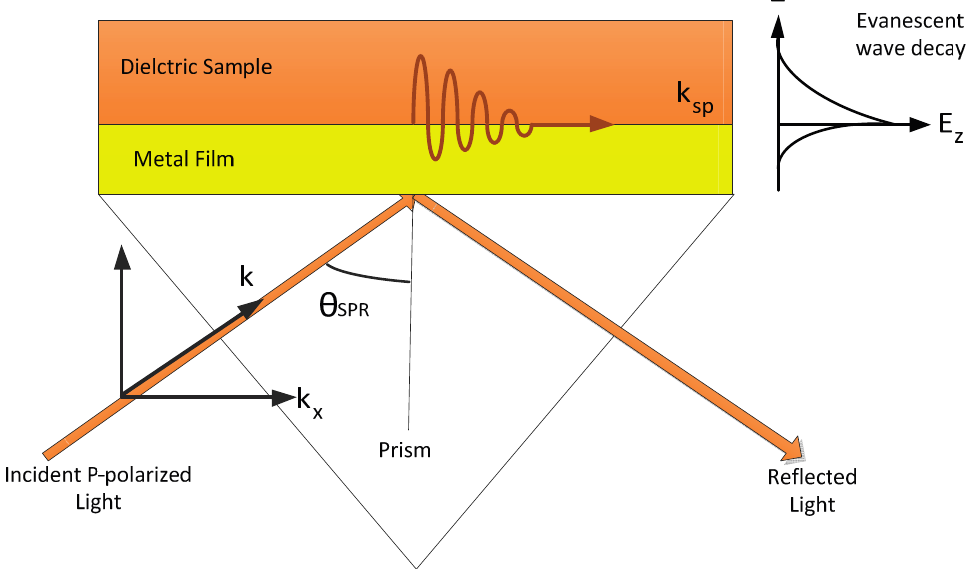
Figure 1. Schematic of SPs propagating in the x-direction. The exponential behaviors of the evanescent field is indicated on the